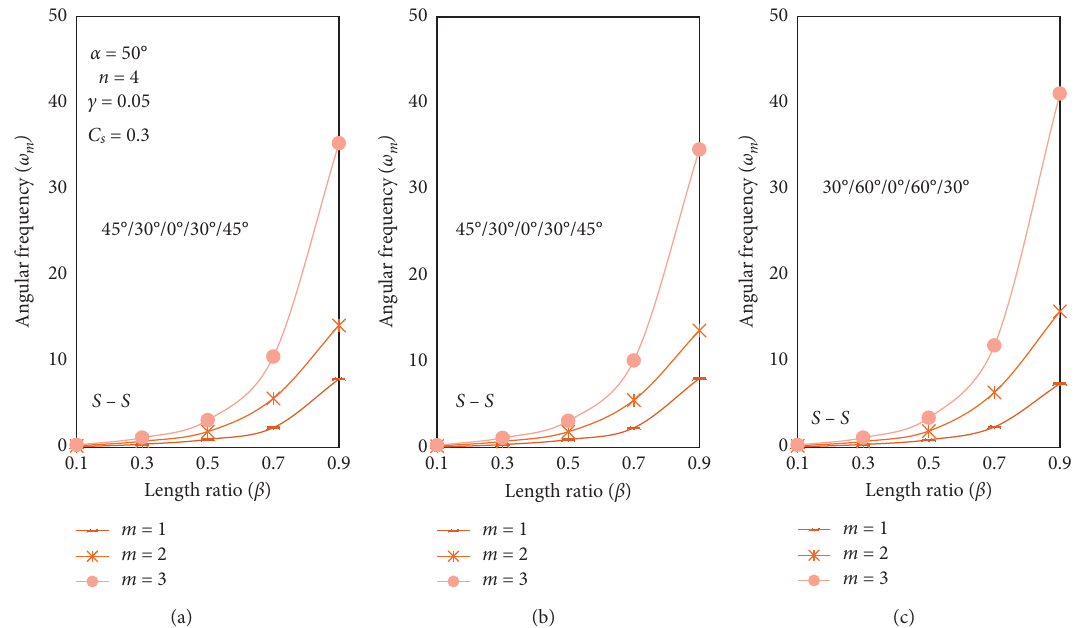
Figure 2: Influence of length ratio on the angular frequency of five-layered conical shells with KE/EGE/GE/EGE/KE material combination.